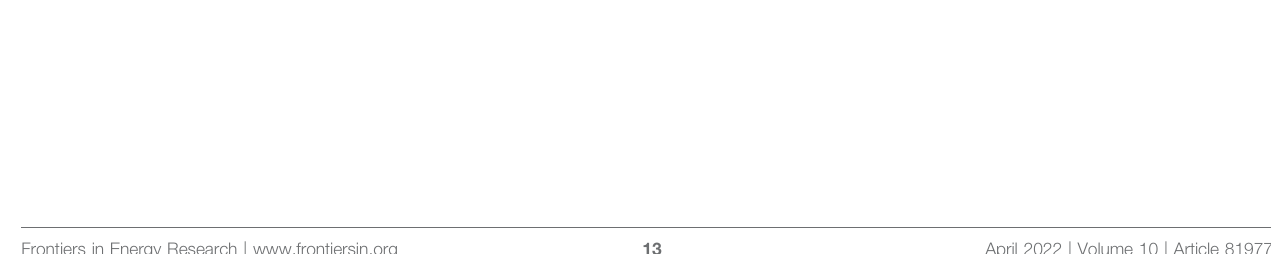
Frontiers in Energy Research |